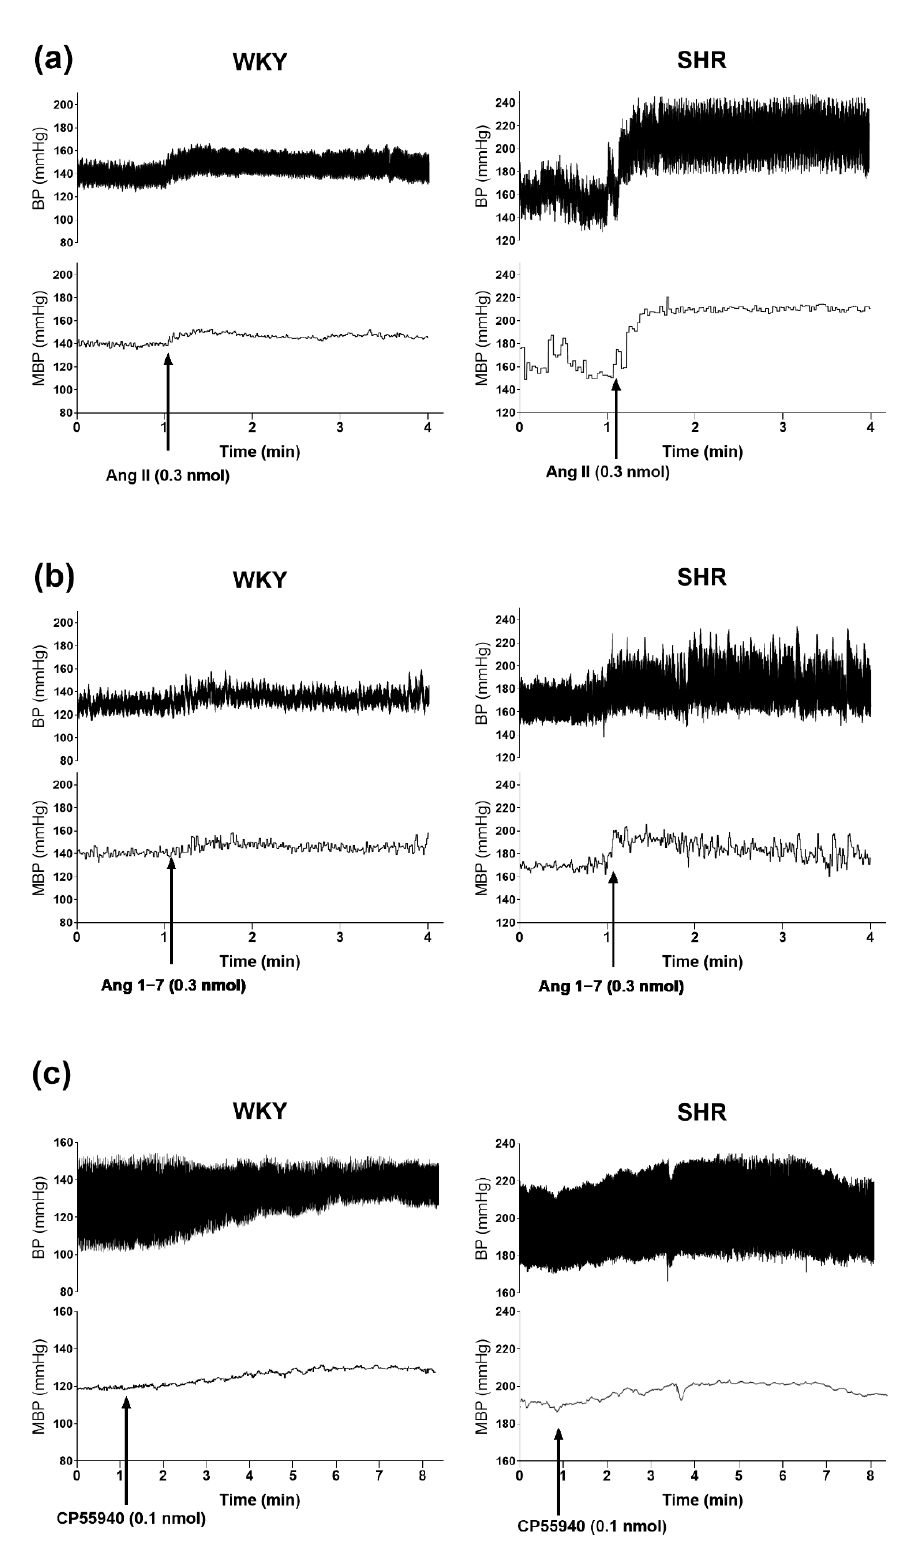
Figure 3. Representative original traces of the pressor effects of angiotensin II ( a ), angiotensin 1–7 ( b ) and CP55940 (after i.v. administration of AM251) ( c ) injected into the paraventricular nucleus of hypothalamus (PVN) on blood pressure (BP) and mean blood pressure (MBP) in conscious Wistar Kyoto (WKY) and spontaneously in hypertensive rats (SHR). Arrows show the moment of application of the particular agonist.